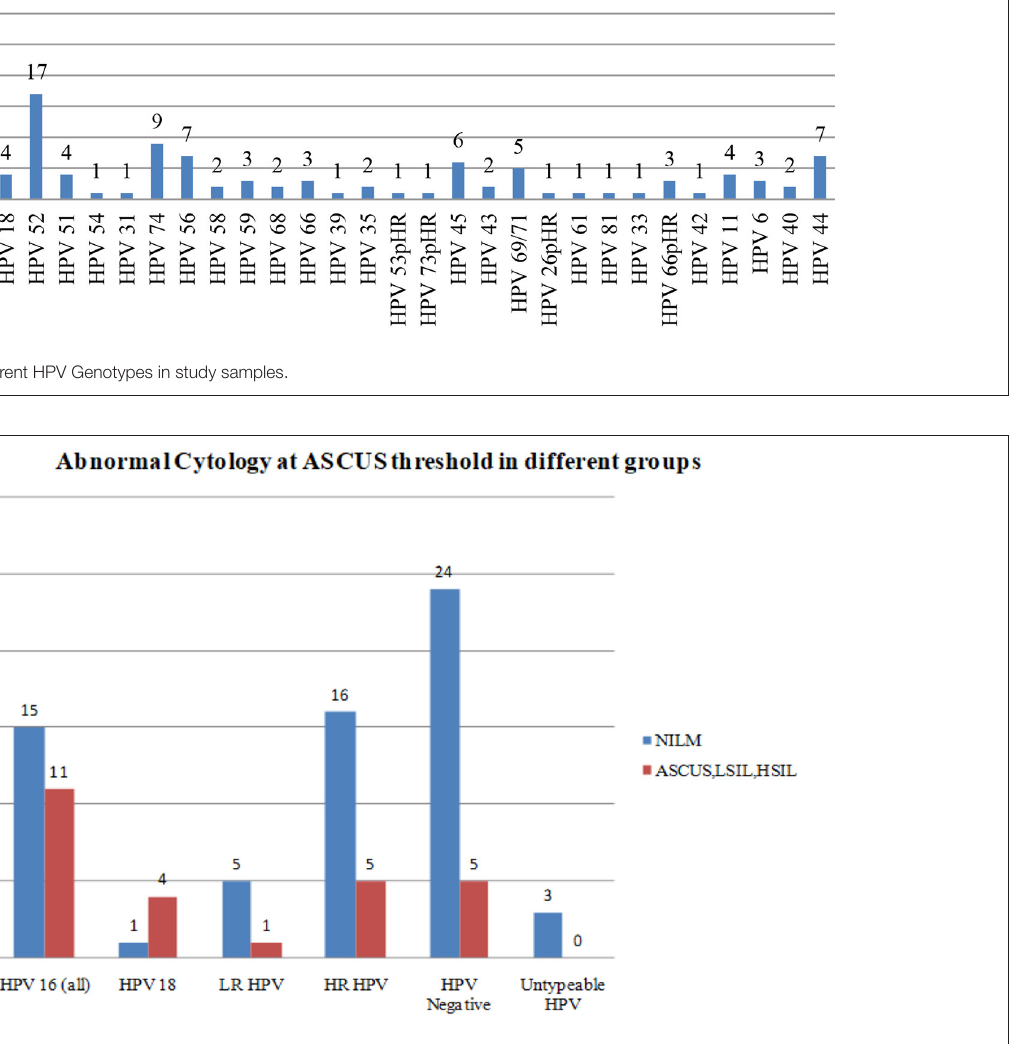
FIGURE 2 | Abnormal cytology in different HPV genotypes at ASCUS